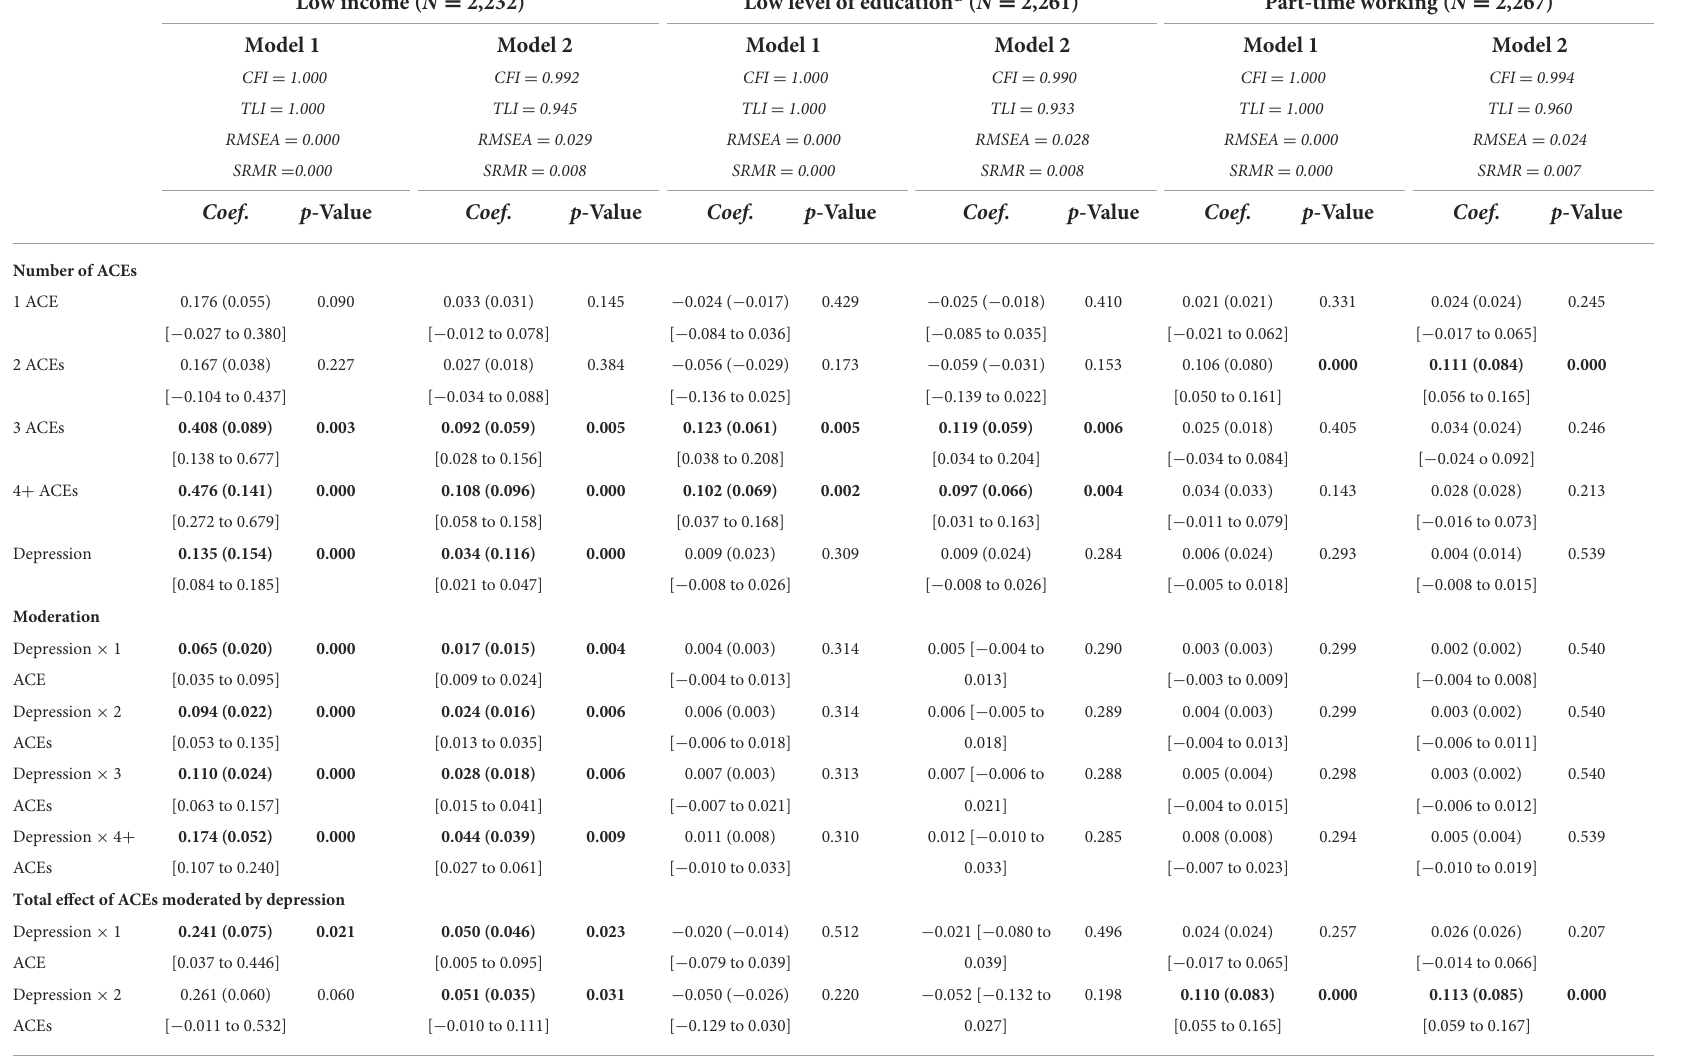
TABLE 3 Results of the structural equation models for low income, low level of education and part-time working with 95% confidence intervals. Low income ( N = 2,232) Low level of education a ( N =